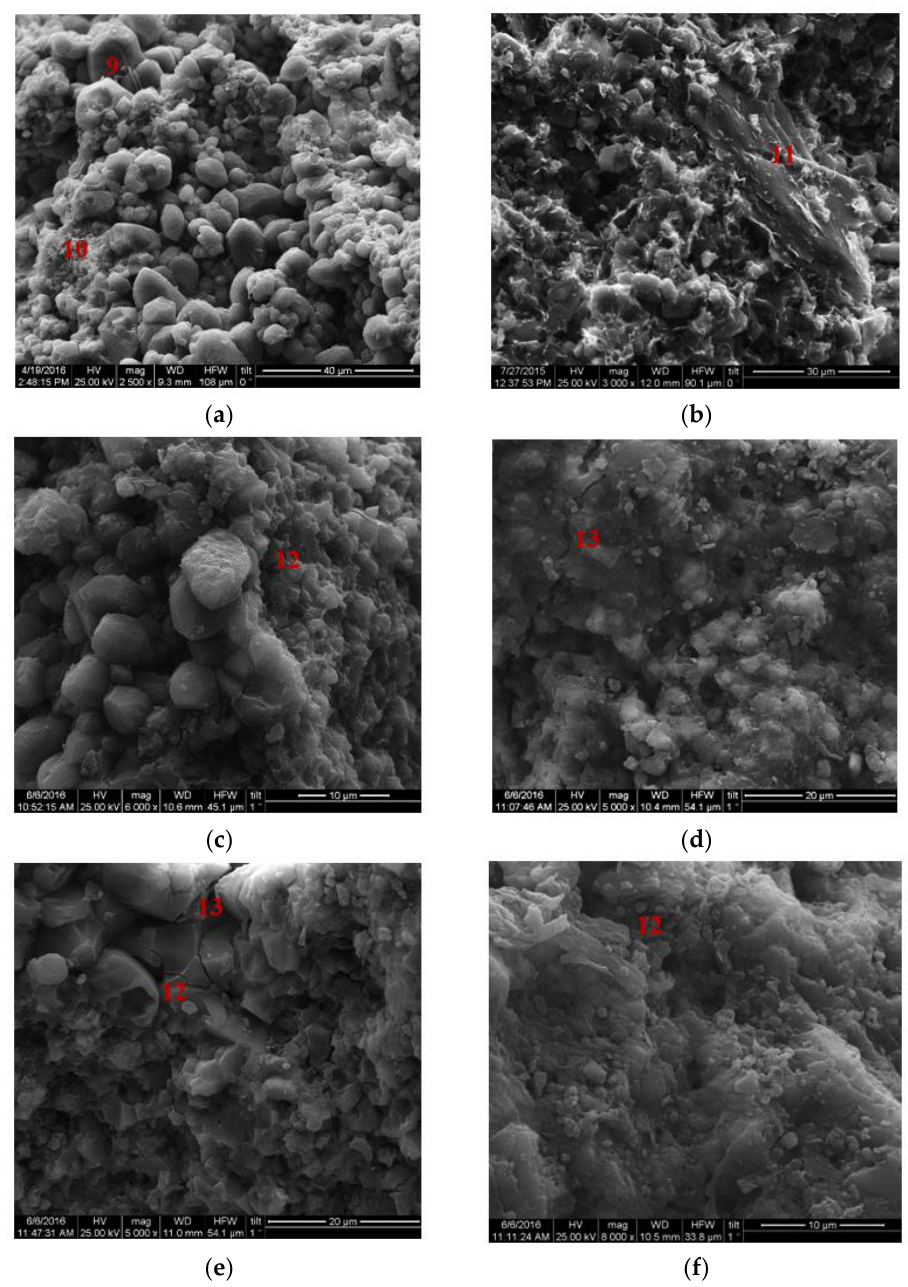
Figure 7. SEM microphotographs of representative stone samples: ( a ) untreated bulk stone (scale bar at 40 μm); ( b ) presence of alumino-silicatic minerals (scale bar at 30 μm); ( c ) treated stone sample with BS OH-100 (scale bar at 10 μm); ( d ) treated stone sample with Funcosil SL (scale bar at 20 μm); ( e ) treated stone sample with KS 300HV (scale bar at 20 μm) and ( f ) treated stone sample with BS 1001 (scale bar at 20 μm).